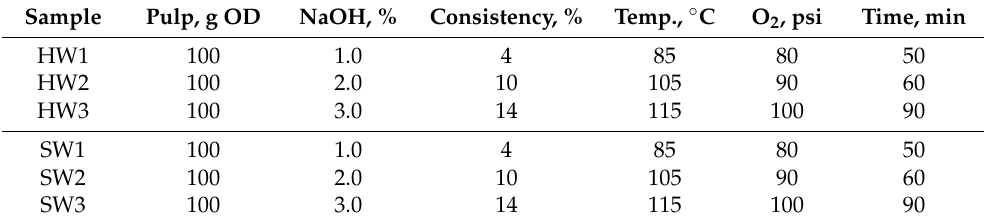
Table 2. The conditions for oxidation of fully bleached pulps by Parr reactor.